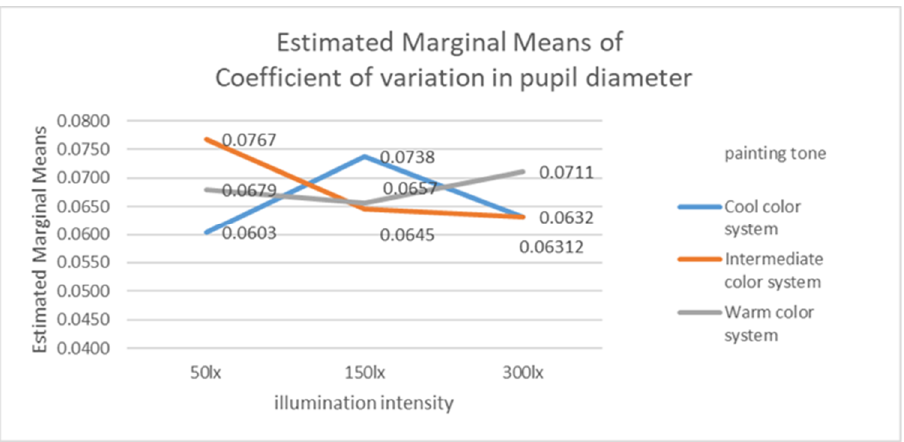
Figure 9. Variation coefficient of the pupil diameter of different tones under different illuminance.